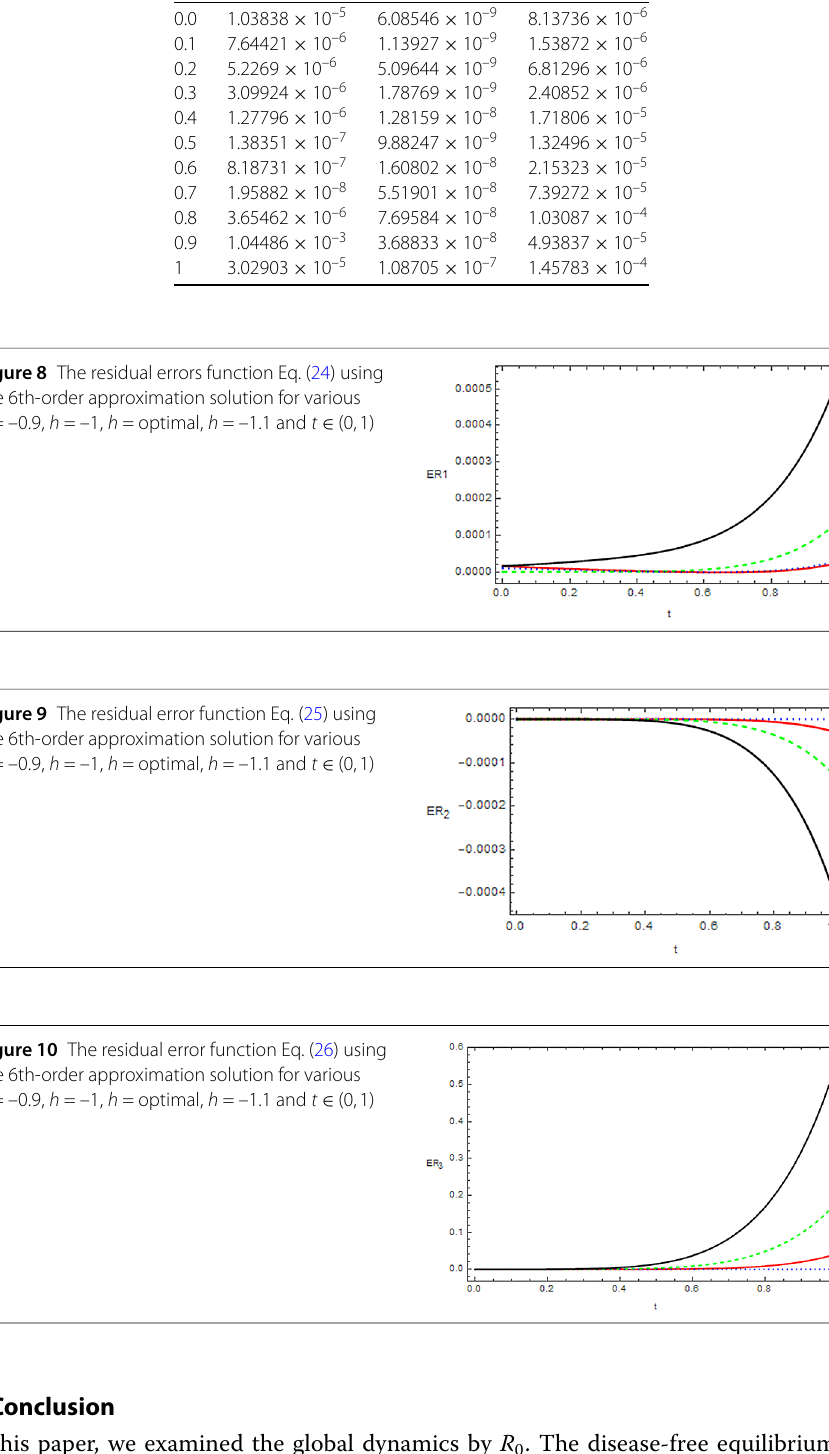
Table 4 The residual errors ER 1 , ER 2 , and ER 3 for various t ∈ (0,1)